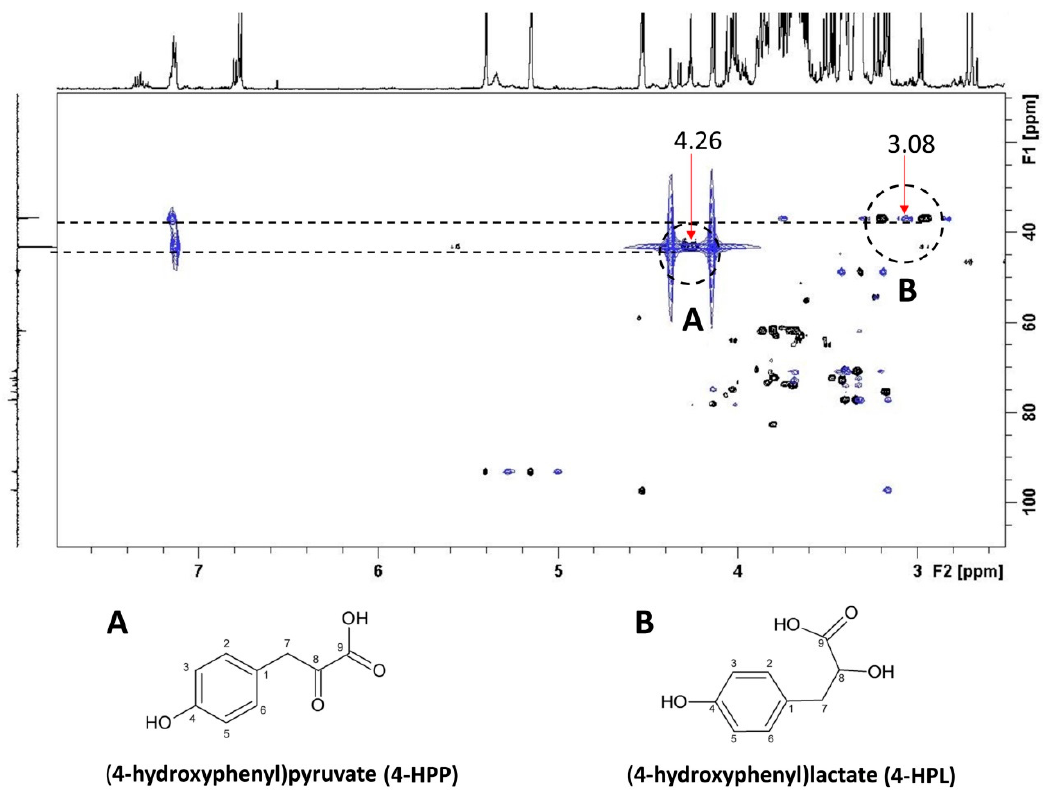
Figure 4. Spectrum overlay of the Heteronuclear Multiple Bond Correlation (HMBC, blue) and Heteronuclear Single Quantum Coherence (HSQC, black) spectra and Distortionless Enhancement by Polarization Transfer ( 13 C DEPT) spectra included as F1 projection. Red arrows indicate the signals at 4.26 ppm and 3.08 ppm in the 1 H frequency domain due to the 13 C-enriched benzylic methylene of 4-HPP and 4-HPL, respectively.